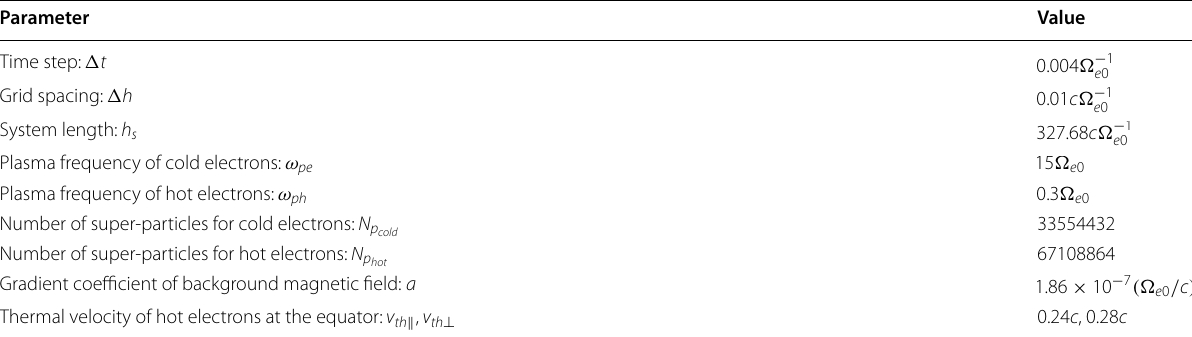
Table 1 Simulation parameters of Case